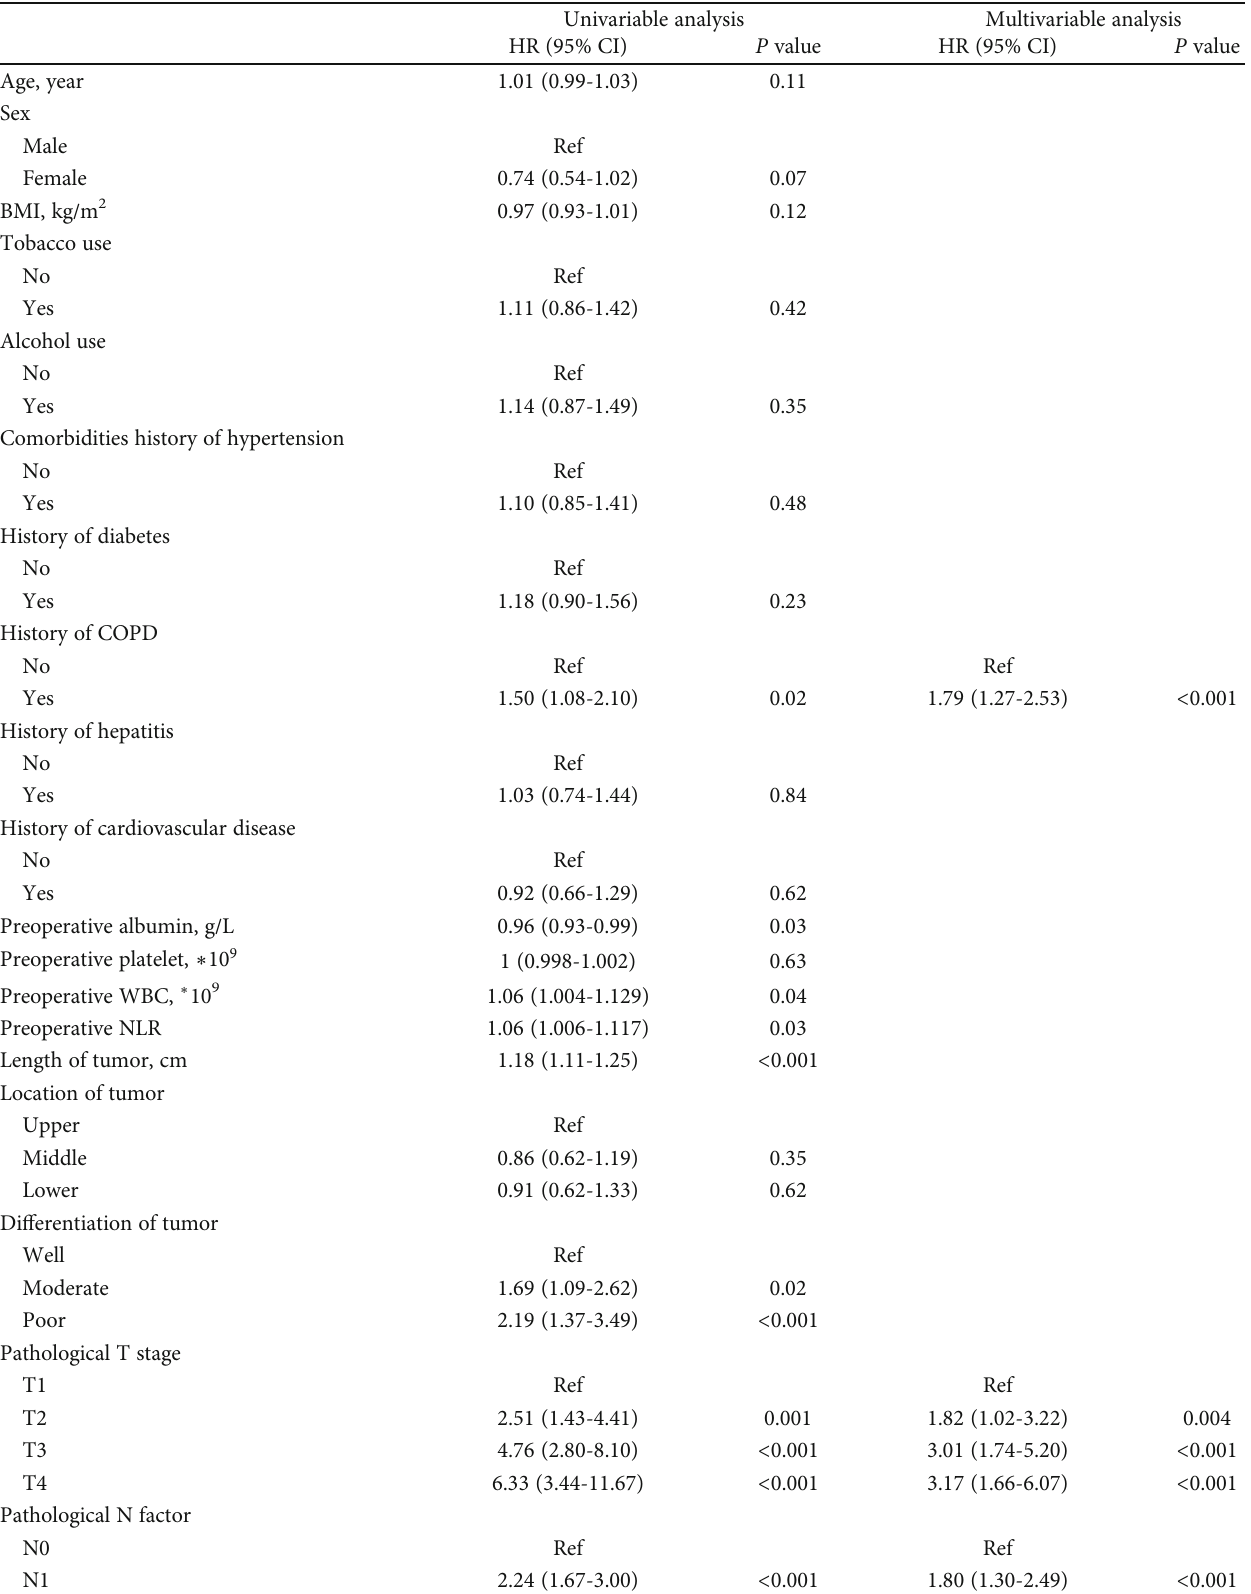
Table 2: Univariable and multivariable Cox analysis of prognostic factors for overall survival in 503 patients with esophageal squamous cell